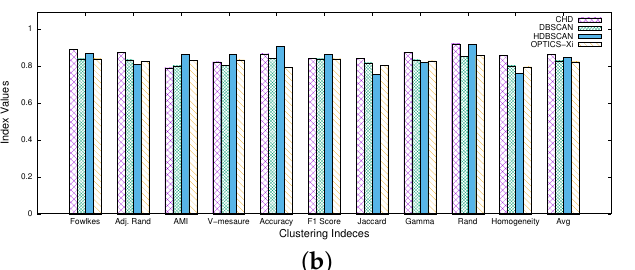
Figure 6. Best clustering results for the four algorithms on the two datasets: chess ( a ) and compound ( b ) datasets.